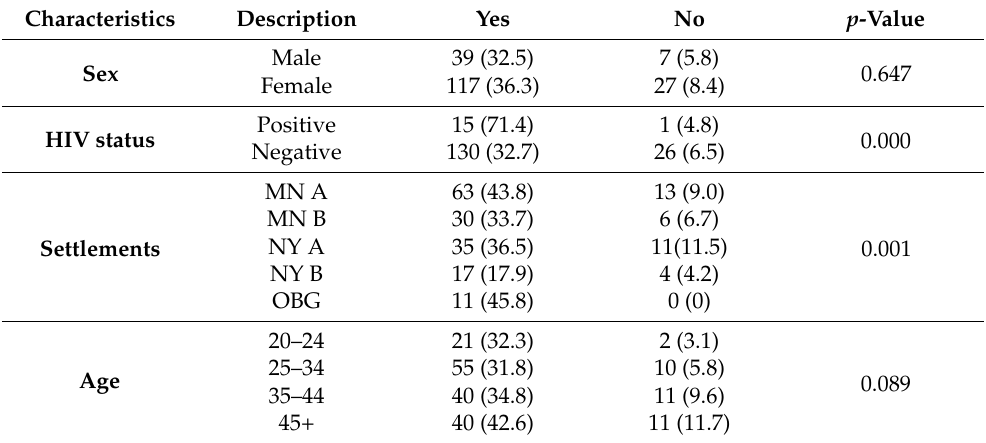
Table 4. Distribution of completion of antibiotic dose by demographic characteristics.